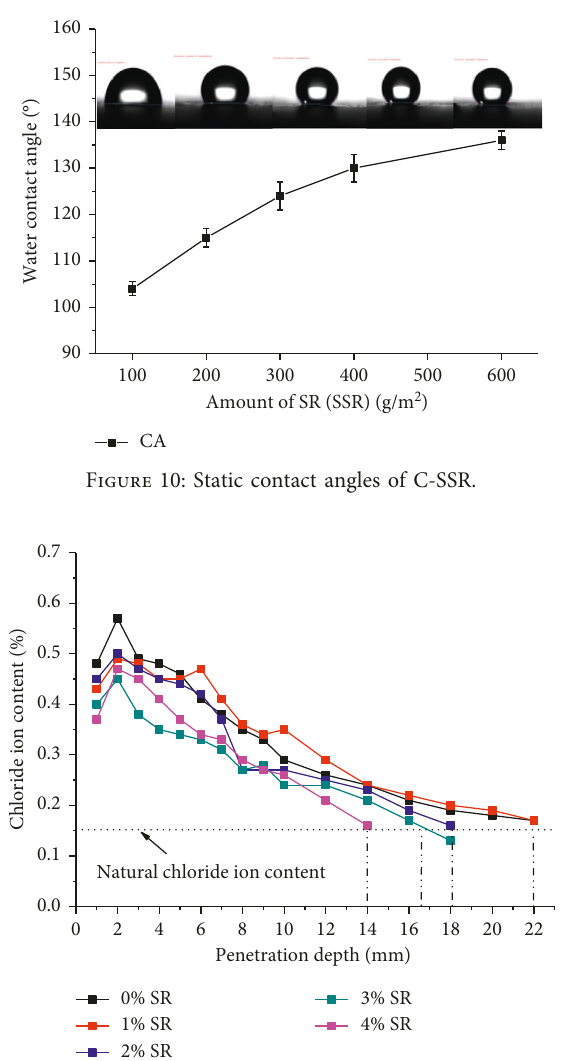
Figure 11: Chloride profiles measured in C-ISR after 28days of immersion in 0.5% NaCl.